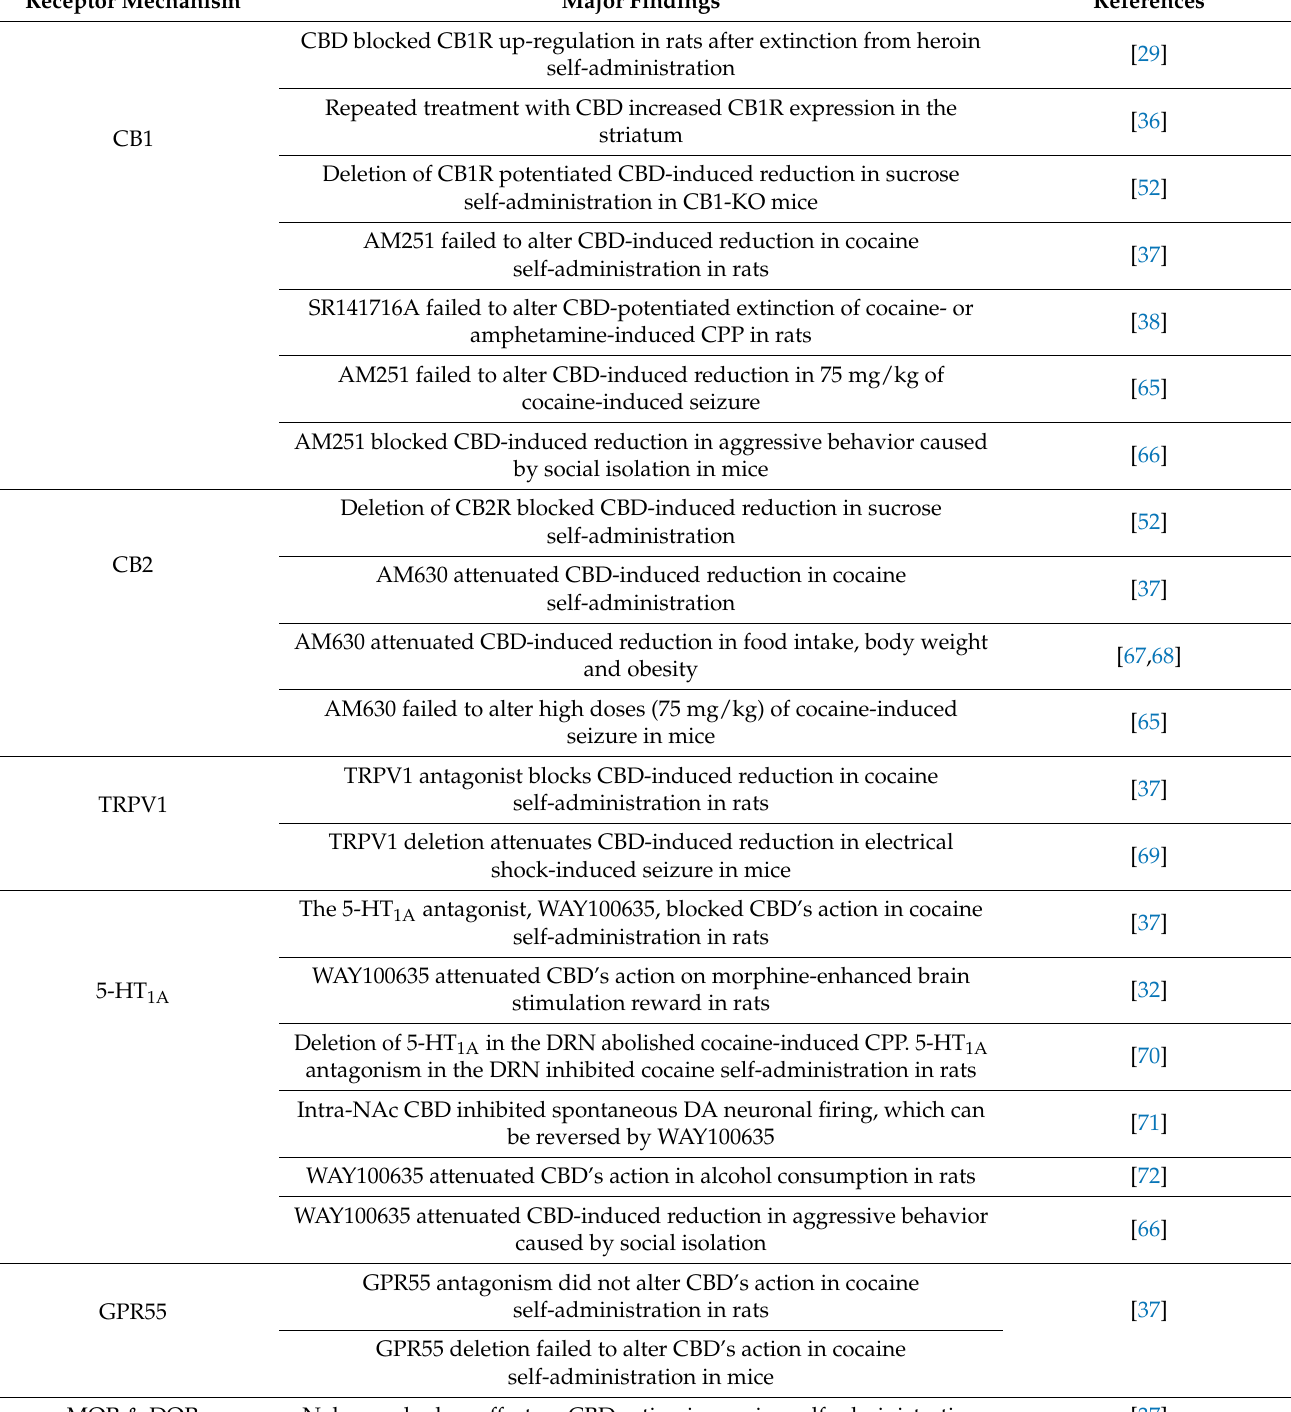
Table 2. Receptor mechanism studies in vivo in reward-related behaviors in experimental animals. Receptor Mechanism Major